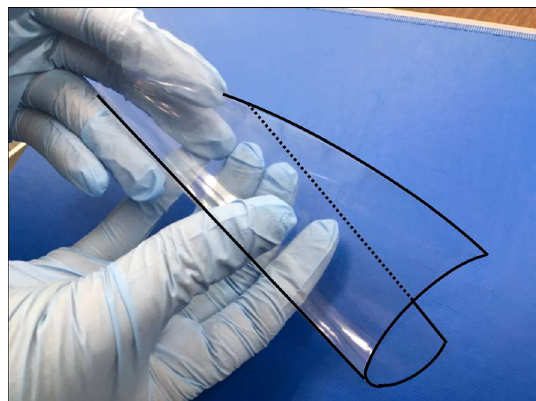
Figure 1. E8002 membrane. E8002 is a flexible three-layered membrane comprising a polylactic acid-based biodegradable polymer containing the antioxidant L -ascorbic acid. For image clarity, the outline of the membrane has been highlighted using a solid and dotted line.